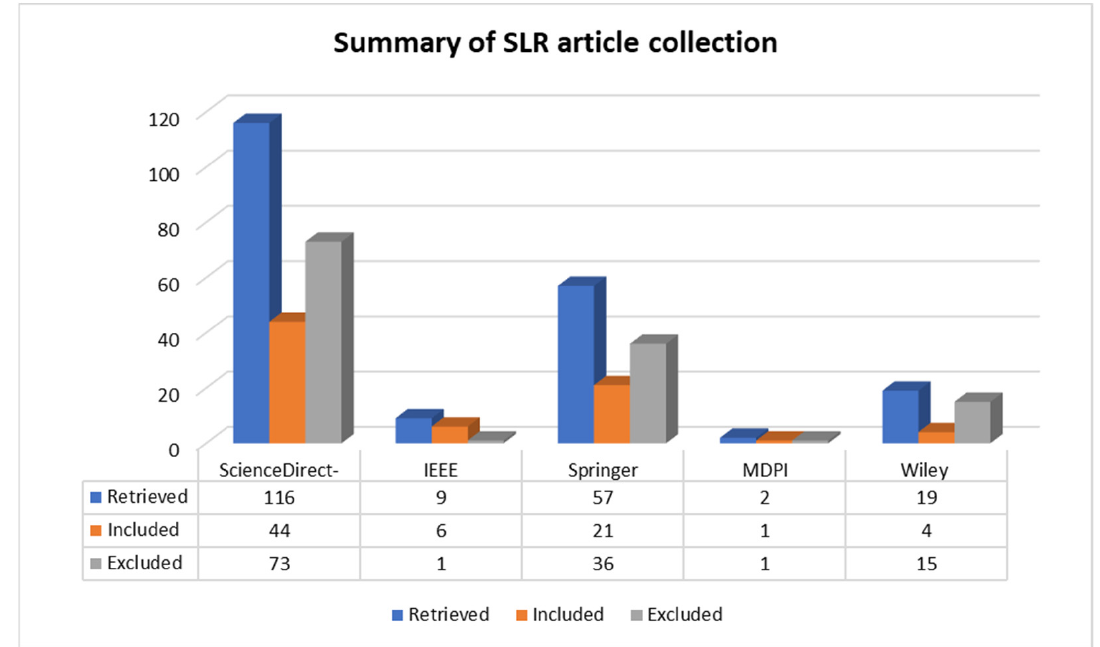
Figure 2. Articles found from the electronic research databases.